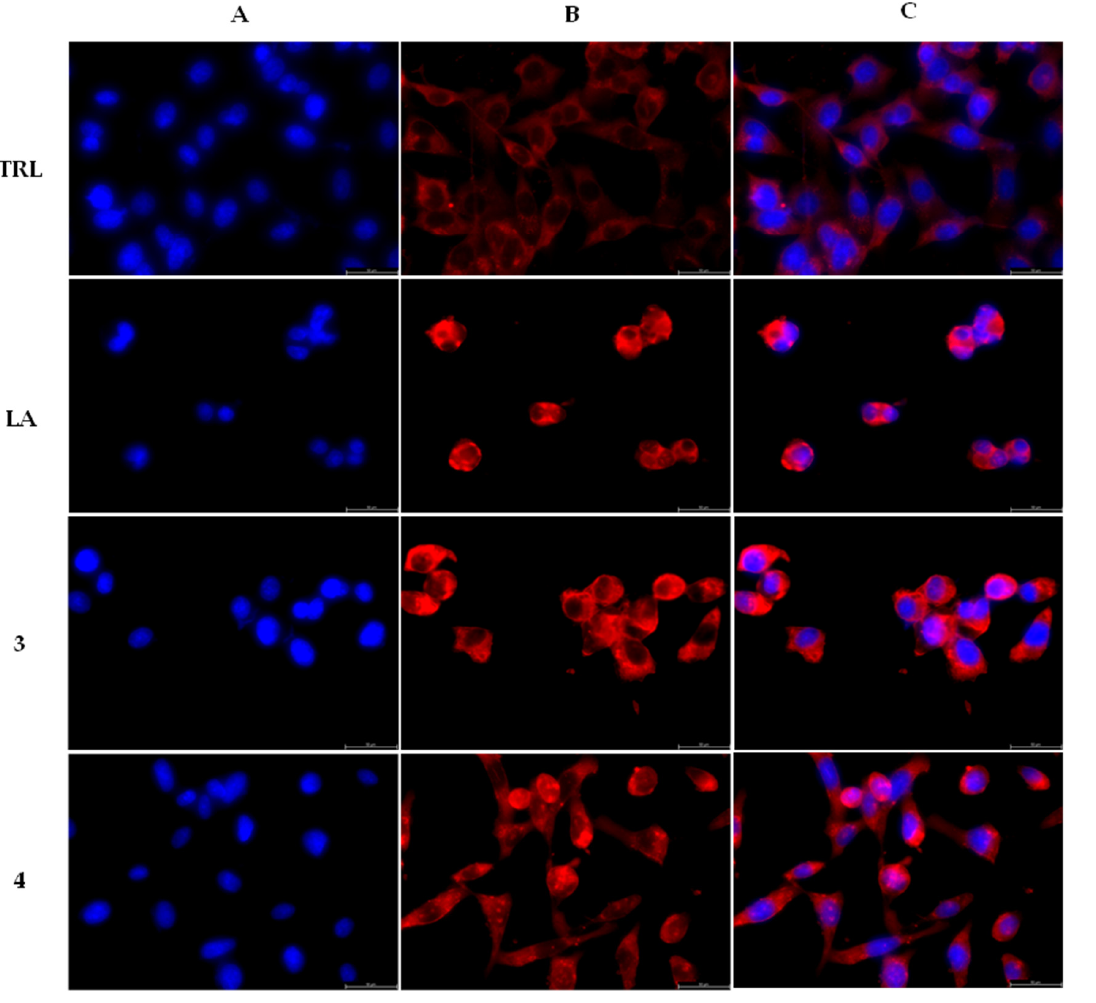
Figure 4. Actin immunofluorescence studies. MDA-MB-231 cells were exposed for 24 h to the vehicle alone (CTRL), 0.1 µ M LA or carbazole derivatives 3 and 4 (used at their IC 50 values). Then the cells were further processed, as indicated in the experimental section. The inverted fluorescence microscope was adopted to observe and image all the immunofluorescence figures (40 × magnification). Panels A: nuclear stain with DAPI ( λ ex/ λ em = 350/460 nm); Panels B: β -actin (Alexa Fluor ® 568; λ ex/ λ em = 644/665 nm); Panels C show a merge. Representative fields are